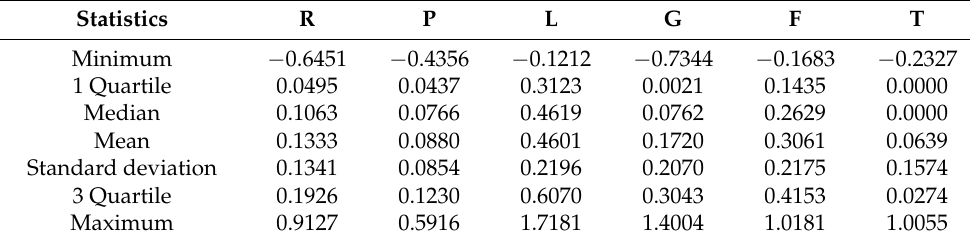
Figure 1. Boxplot statistics. Table 3. Descriptive data